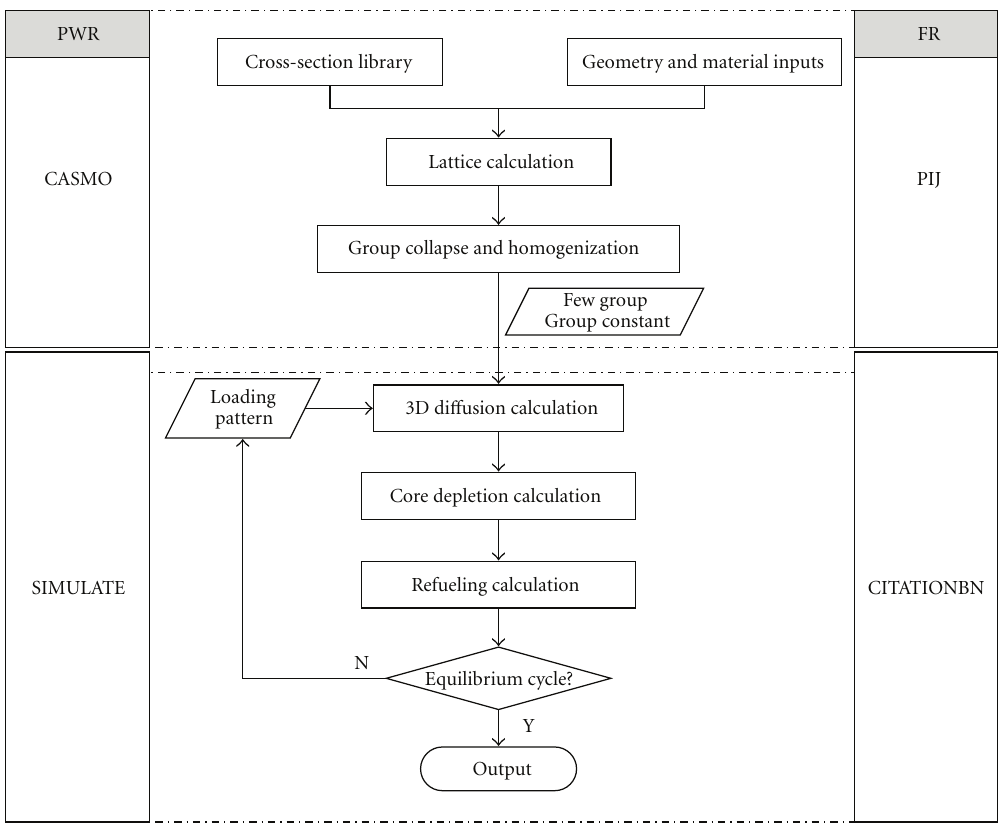
Figure 1: The computational flowchart of reactor core